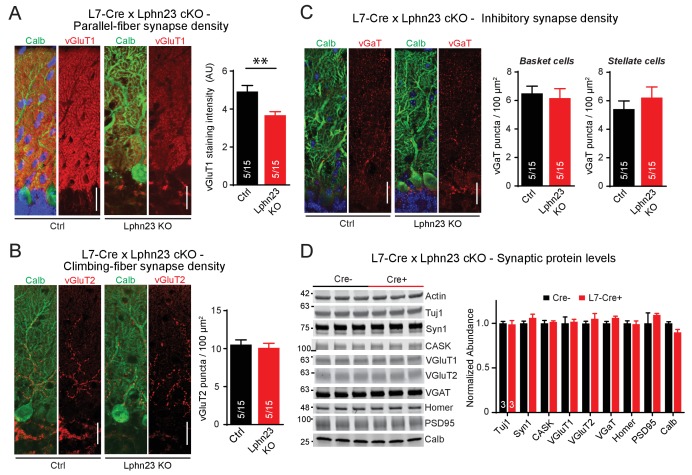
Double deletion of Lphn2 and Lphn3 in Purkinje cells decreases parallel-fiber synapse staining but has no effect on climbing-fiber synapse density, inhibitory synapse density in the cerebellar cortex or synaptic protein composition of the cerebellum.(A) Deletion of both Lphn2 and Lphn3 from Purkinje cells reduces parallel-fiber synapse staining as shown by reduced vGluT1 staining intensity that specifically labels parallel-fiber synapses and has been previously shown to be a proxy for parallel-fiber synapse density (left, representative images of vGluT1 in red and calbindin in green; right, summary graph). (B) The Lphn2/3 double deletion from Purkinje cells does not alter climbing-fiber synapse density as visualized by vGluT2 puncta staining. Climbing-fiber synapse density was quantified by counting vGluT2 puncta (red) co-stained with calbindin (green) as a function of Purkinje cell dendrite area (left, representative images; right, summary graph). (C) The Lphn2/3 double deletion from Purkinje cells does not alter inhibitory basket-cell or stellate-cell synapse density as shown by vGaT puncta staining. Basket-cell synapse density was quantified by measuring vGaT puncta density (red) on Purkinje cell bodies identified by calbindin staining (green), while stellate-cell synapse density was quantified by measuring vGaT puncta density in the upper half of the molecular layer (left, representative images; right, summary graph). (D) The Lphn2/3 double deletion from Purkinje cells does not alter synaptic protein levels from whole cerebellum (top, representative immunoblots; bottom, summary graph of protein abundance normalized to actin loading controls, n = 3 each). All scale bars are 20 µm. Data are represented as means ± SEM; numbers in bars in A, B, C represent independent experiments/number of sections imaged. **p<0.01 (two-tailed t test).